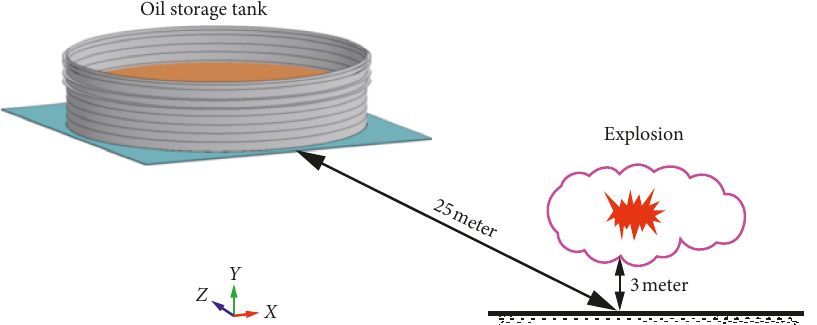
Figure 9: The relative distance between the storage tank and the explosion.